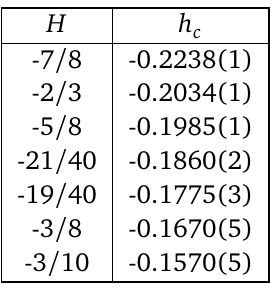
( N )] for N = 2 4 , ··· 2 7 as a function of N H . The lines are the best Figure 18: (cid:69) [ h c fits to the form (56) with ν = − 1 / H for different H s. The intercepts with the vertical N H = 0 axis ( N → ∞ limit), give the estimation for h Table 10: Critical level obtained from scaling (56), for the surfaces